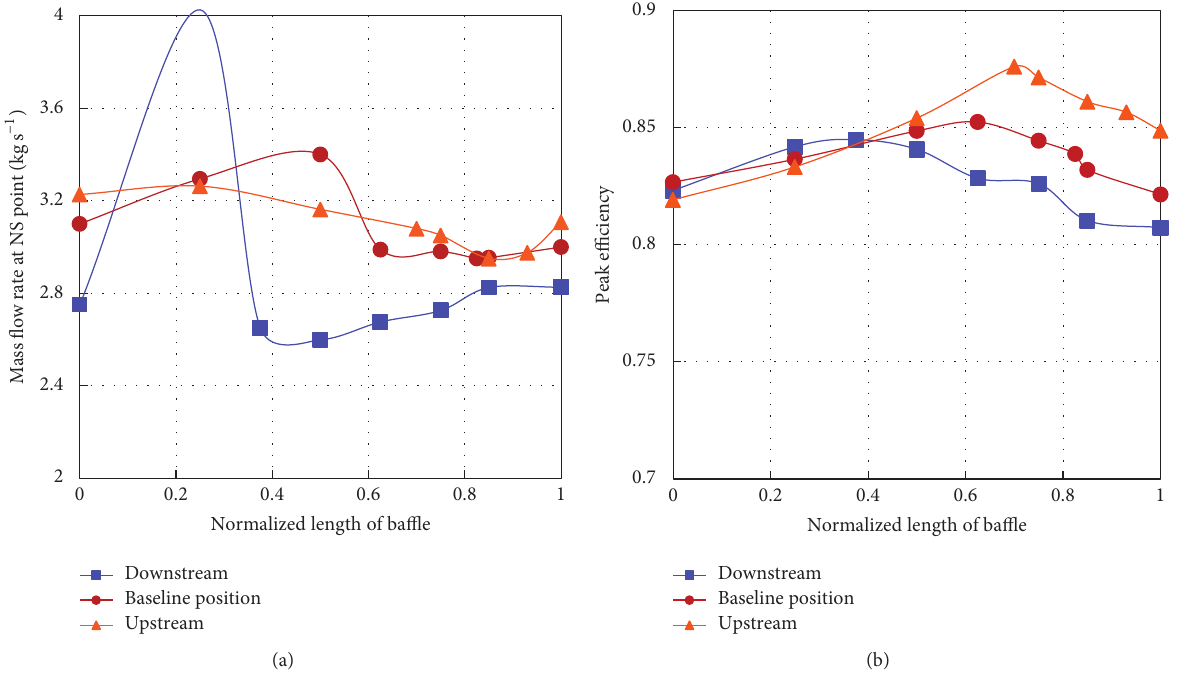
Figure 20: The coupled effect of slot position and the baffle length on efficiency and flow